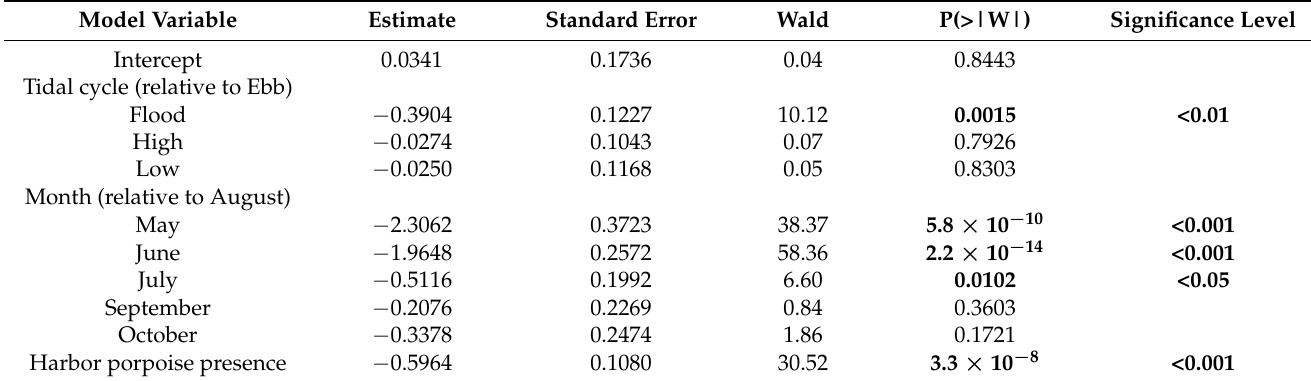
Table 2. Binomial GEE-GLM output (Dolphin presence in Brandon Bay). The output shows the estimate, standard error, Wald test statistic, and p -values for each predictor. Significant predictors are highlighted in bold.